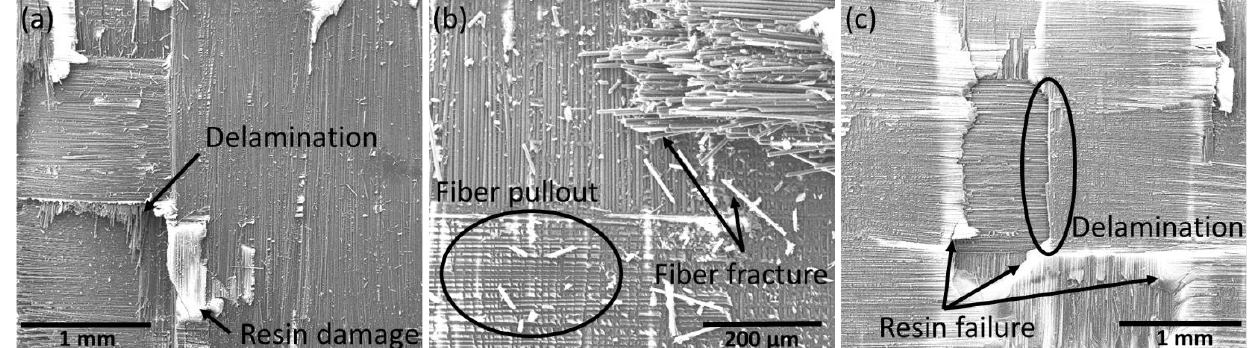
Figure 10. SEM micrographs showing different failure modes in the samples repaired at room temperature after flexural testing ( a ) delamination, ( b ) fiber pullout and fracture and ( c ) resin failure and delamination.